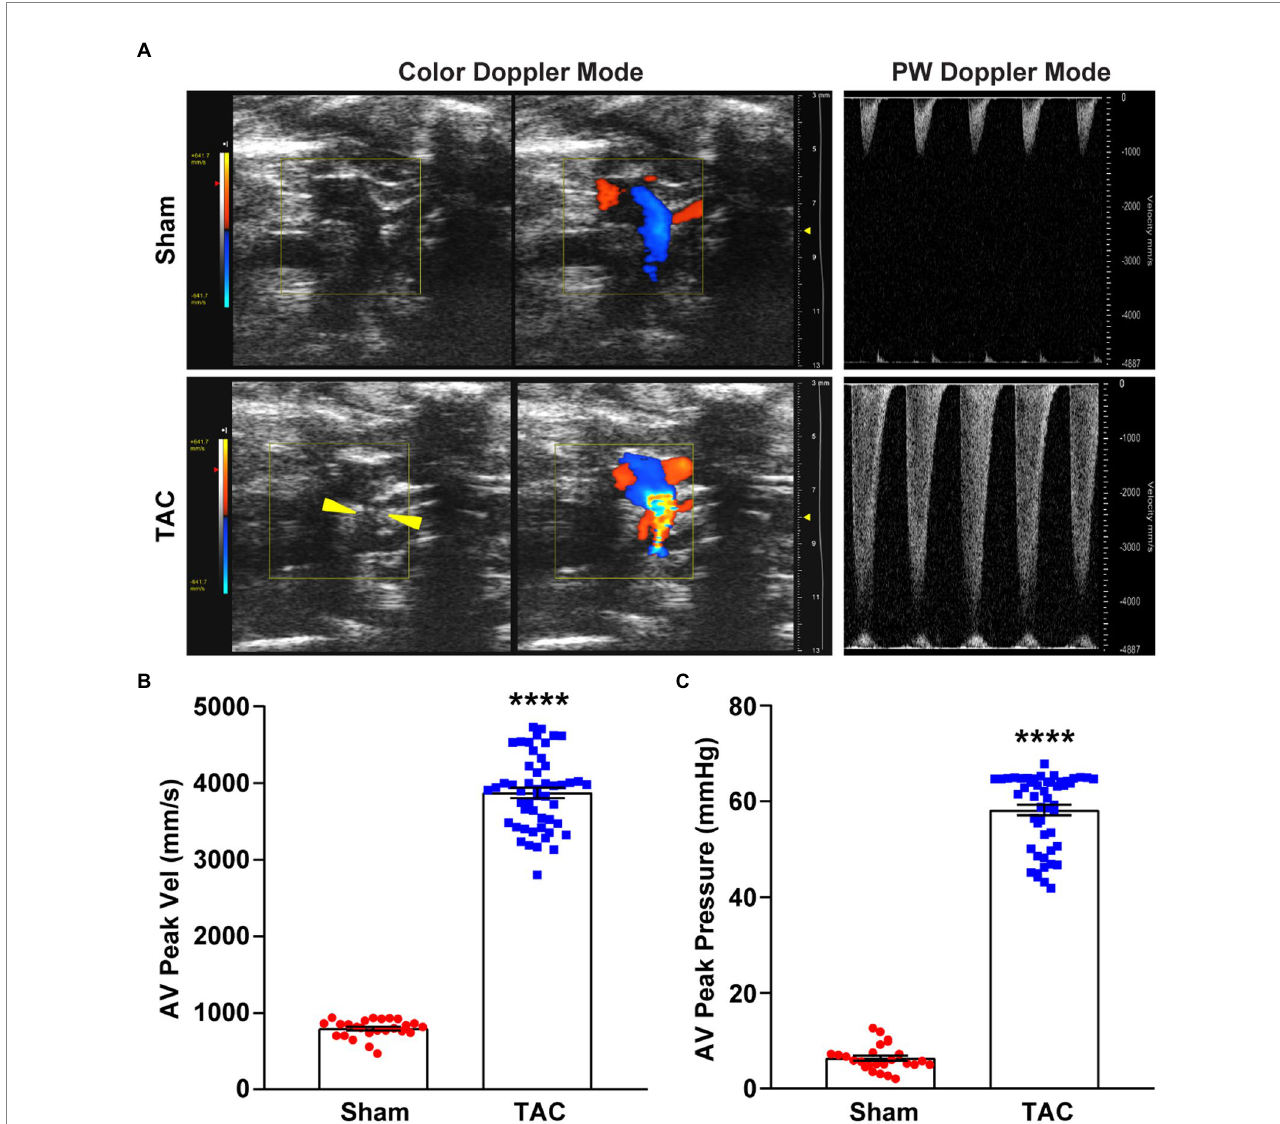
FIGURE 3 Color and pulsed-wave Doppler ultrasound. (A) Representative color Doppler imaging of an aortic flow velocity peak of the non-ligated (sham) mouse (top) and the ligated (TAC) mouse (bottom). The constriction between the two carotid arteries on the aortic arch is visible (yellow arrowheads). (B) Quantification of the AV peak velocity after surgery. (C) AV peak pressure was calculated by doppler velocities. n = 25~50. Unpaired t -test for two-group comparisons, **** p < 0.0001 vs.